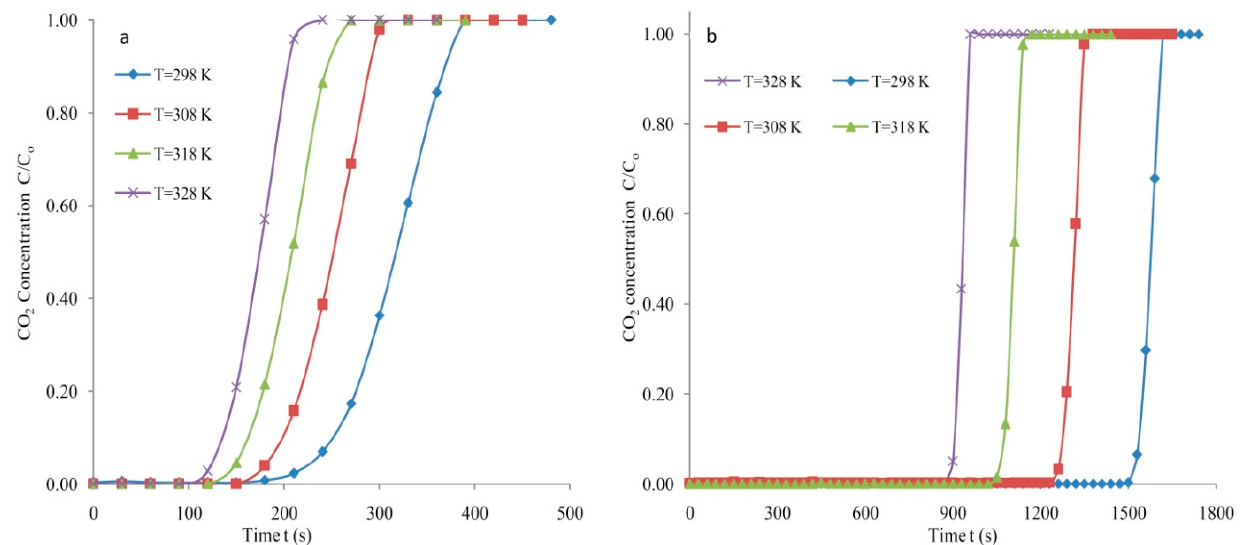
Figure 8. Breakthrough response at various temperatures at F = 4 lpm, C o = 5% ( a ) SG and ( b ) AC.